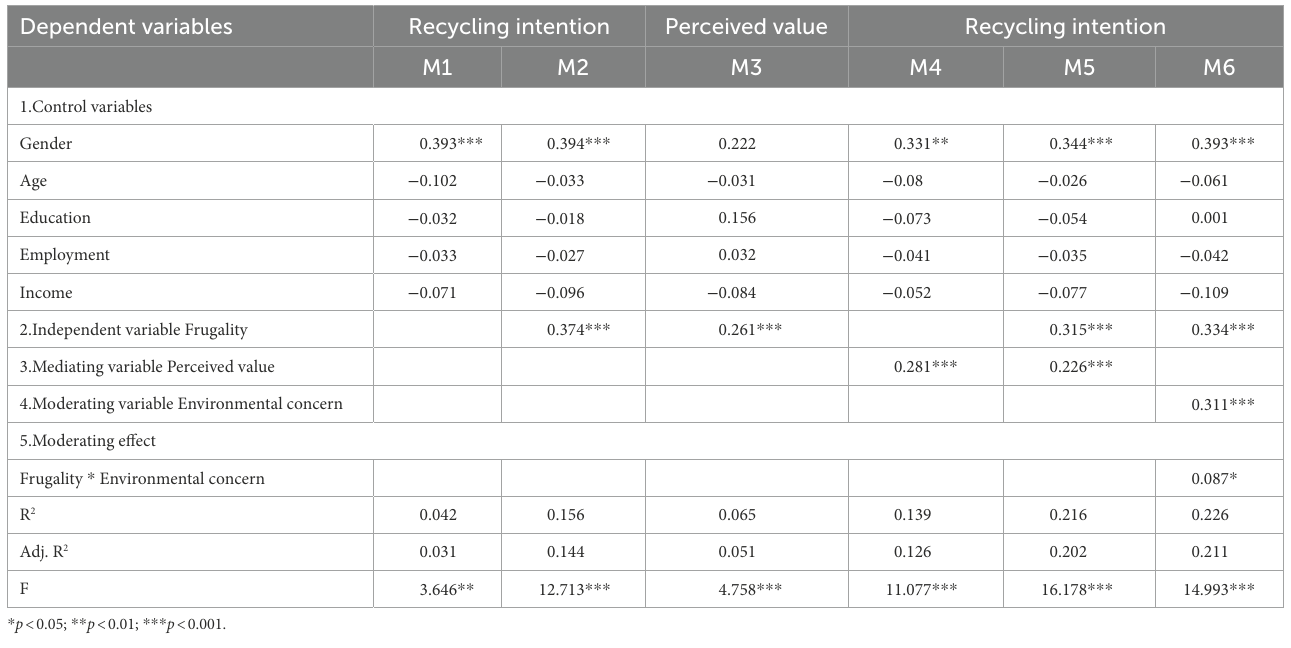
TABLE 4 Hierarchical regression result.